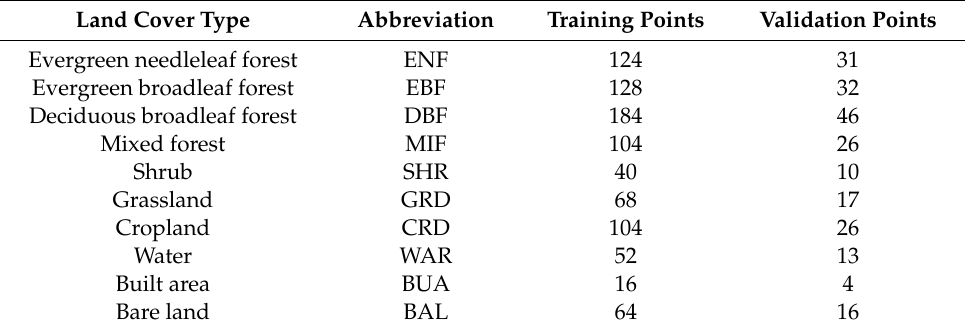
Table 1. Number of training and validation data for each